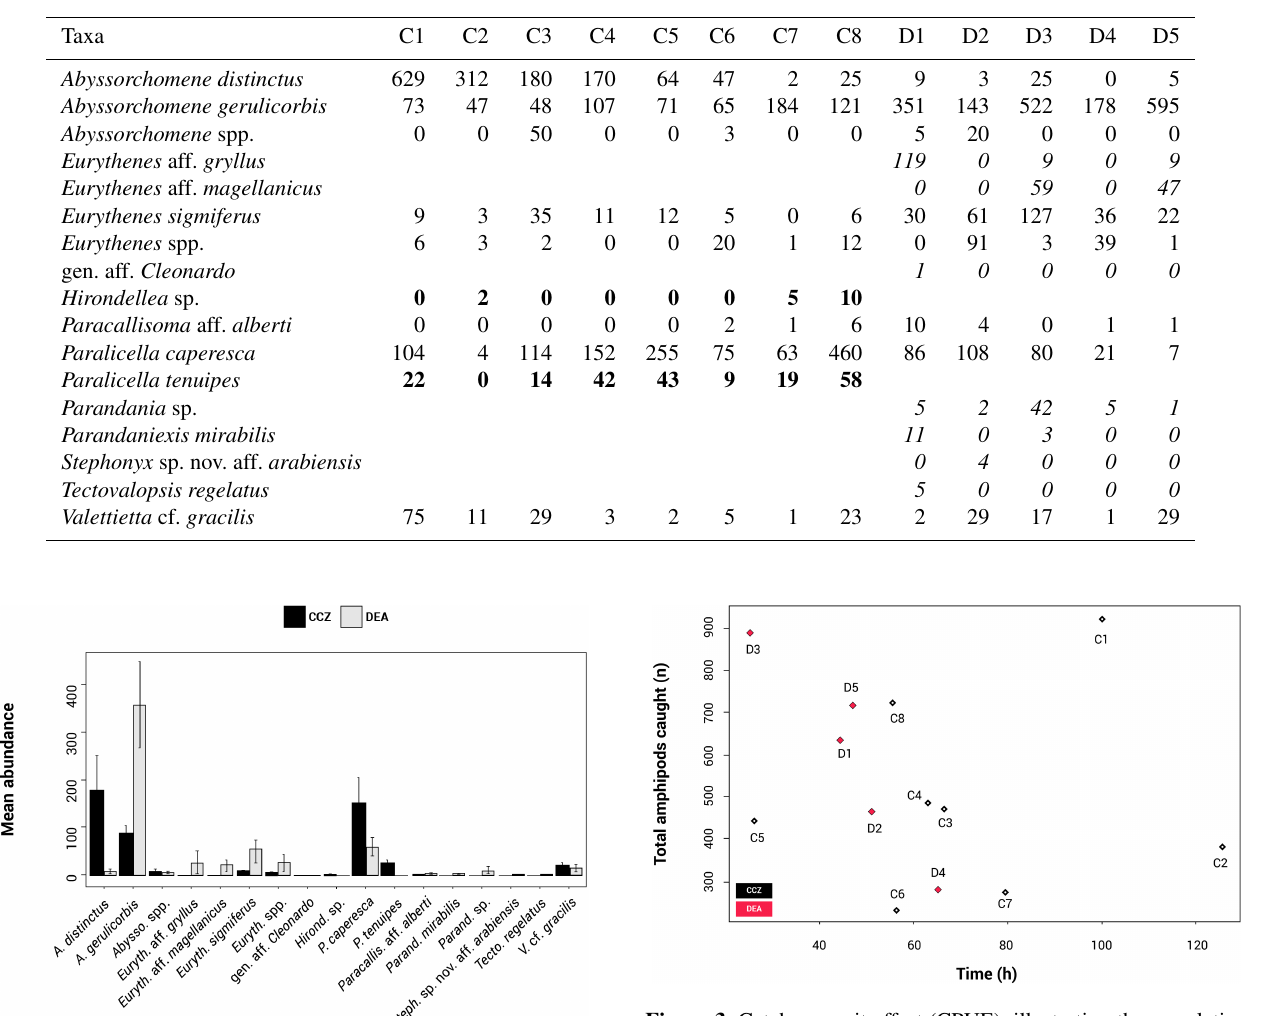
Figure 3. Catch per unit effort (CPUE), illustrating the correlation between sampling time and number of individuals collected. Only the longer than 15mm fraction was included